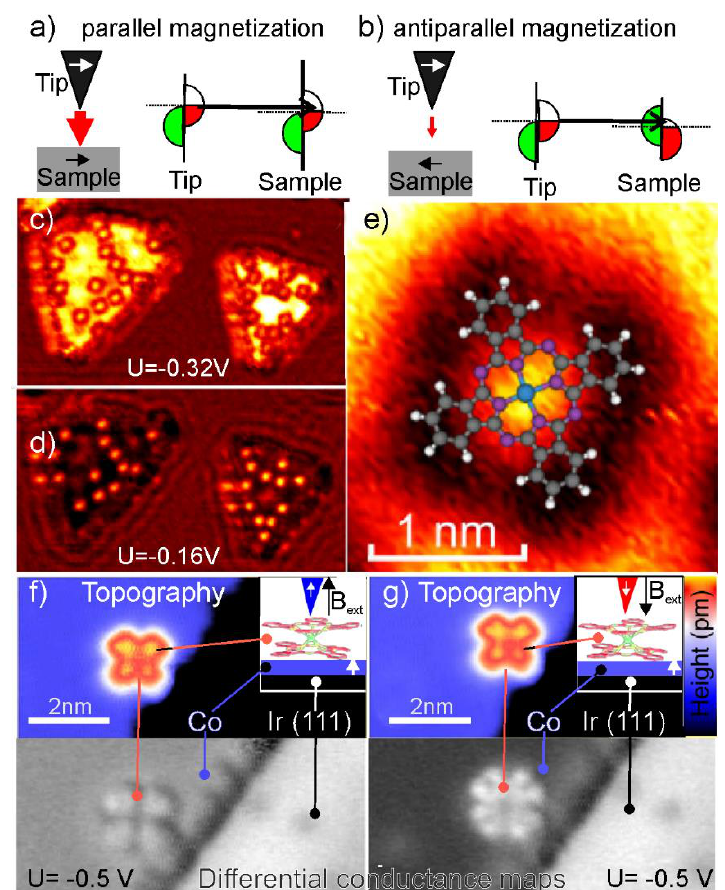
Figure 15. ( a , b ) representation of the spin polarized scanning tunneling microscopy (SP-STM) principle. In magnetic materials the density of states largely depends on the two different spin orientations: Parallel (higher tunneling current) or antiparallel (lower tunneling current) one; ( c , d ) spin-polarized tunneling conductance maps for Co phatolocyanine taken at −0.32 V and −0.16 V (image size: 40 × 20 nm 2 ); ( e ) map of a selected region in ( c ) (2.6 × 2.6 nm) with molecular structure model superimposed. Reprinted with permission from [170], copyright 2008 by American Physical Society; ( f , g ) topographies (top panels) and the associated spin-resolved differential conductance maps (bottom panels) of a single TbPc 2 molecule laying on a metal Co-layered Ir (111) surface for parallel (left panels) and antiparallel (right panels) magnetization alignments. In the top insets of ( f ) and ( g ) schemes of the operational conditions with the superimposed molecular structure model of TbPb 2 , are illustrated. Adapted from [171], published by Nature Publishing Group, 2012.